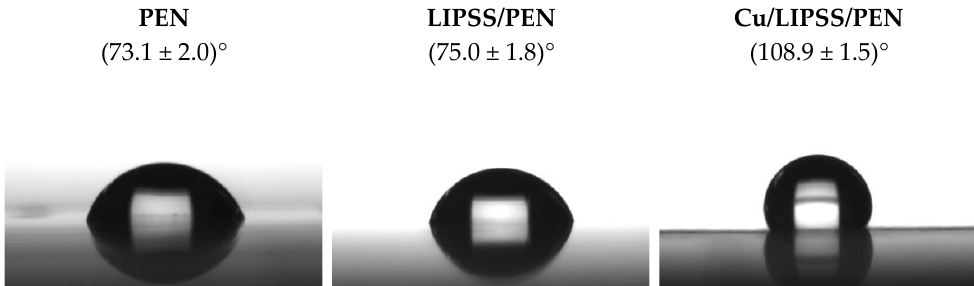
Figure 6. Images of water droplets on the surfaces of PEN, LIPSS/PEN, and Cu/LIPSS/PEN with corresponding contact angles.